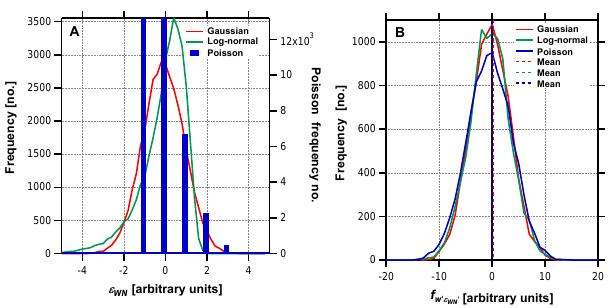
Figure 3. Panel (a) shows the frequency distributions of Gaussian, log-normal and Poisson noise ( ε WN ) of identical standard deviation. Panel (b) shows the frequency distributions of the flux calculated from the unstructured white noise over a period of 5000 iterations. The mean average flux for each noise distribution are marked with dashed lines, which are all close to zero and consistently confirm that no systematic bias is introduced to a flux measurement regard- less of the type of noise